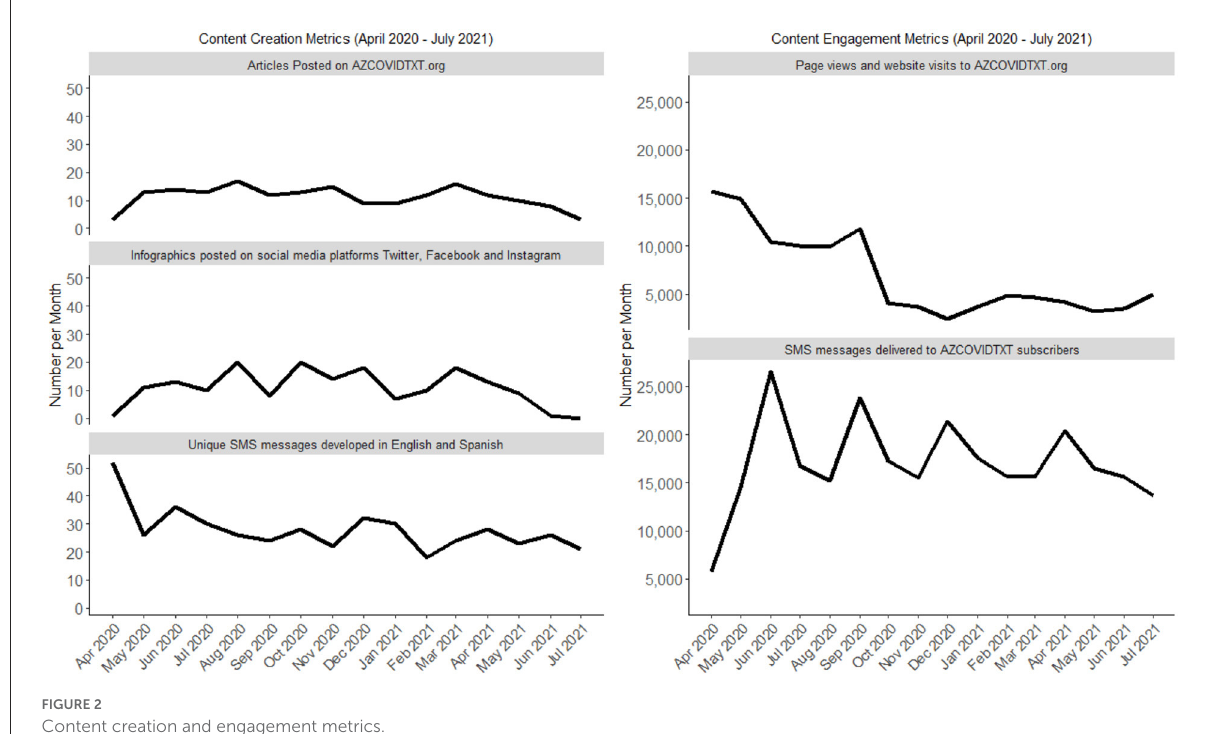
FIGURE2 Content creation and engagement